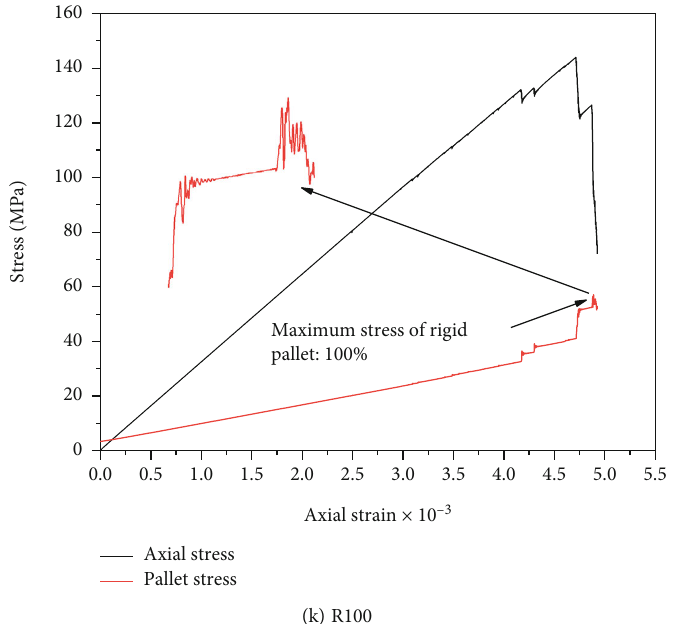
Figure 12: Stress-strain curve of rock sample and pallet.